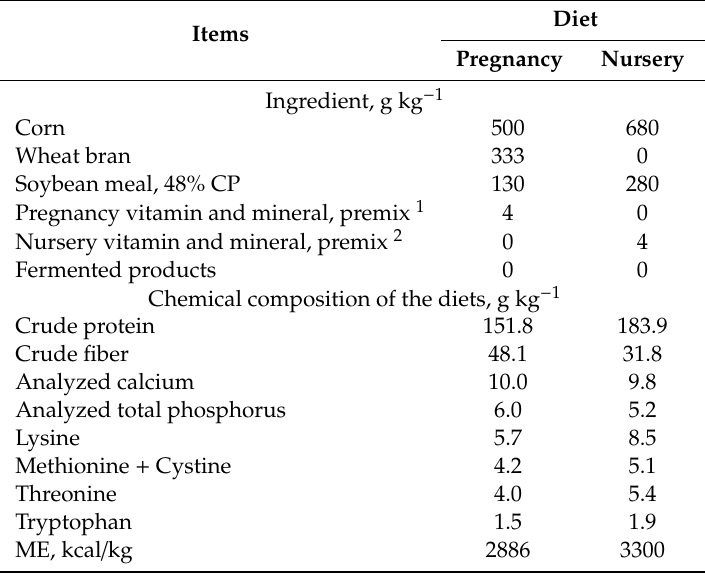
Table 1. Basal diet composition and nutritional